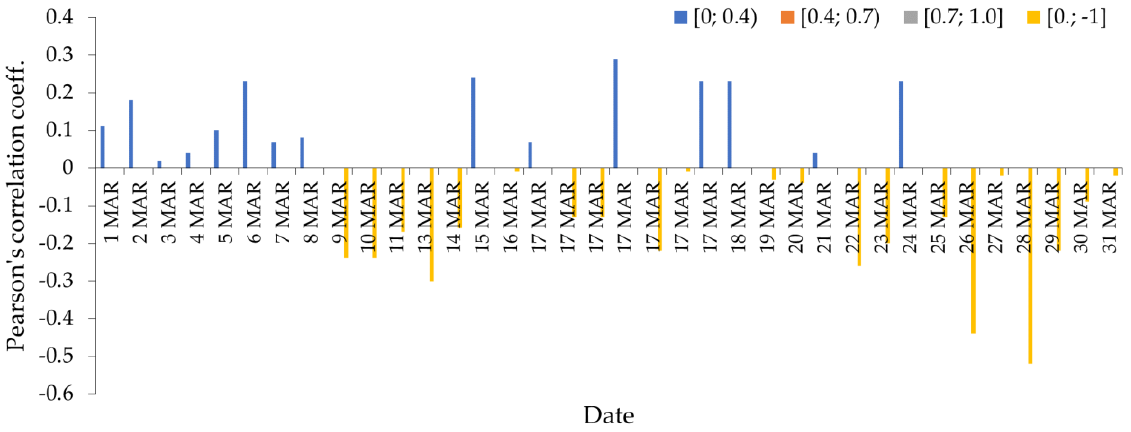
Figure 9. Pearson’s correlation coefficients in relation to discrepancies and ROTI for all 36 peak sub- sets.